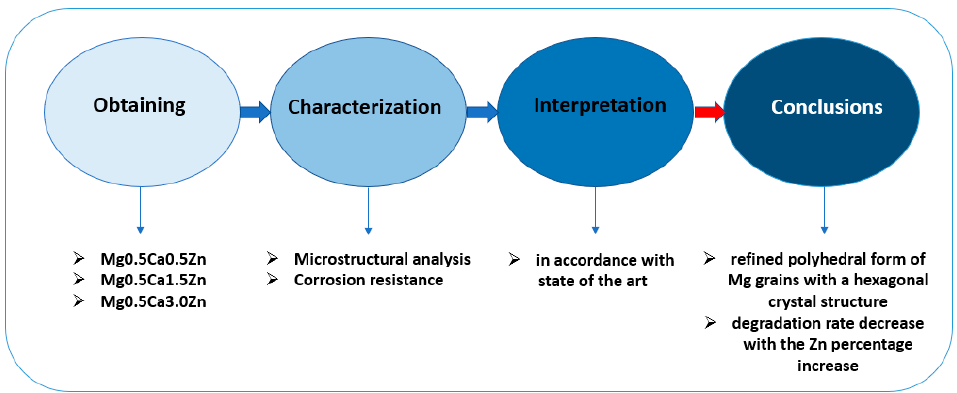
Figure 1. Schematic overview of the paper.